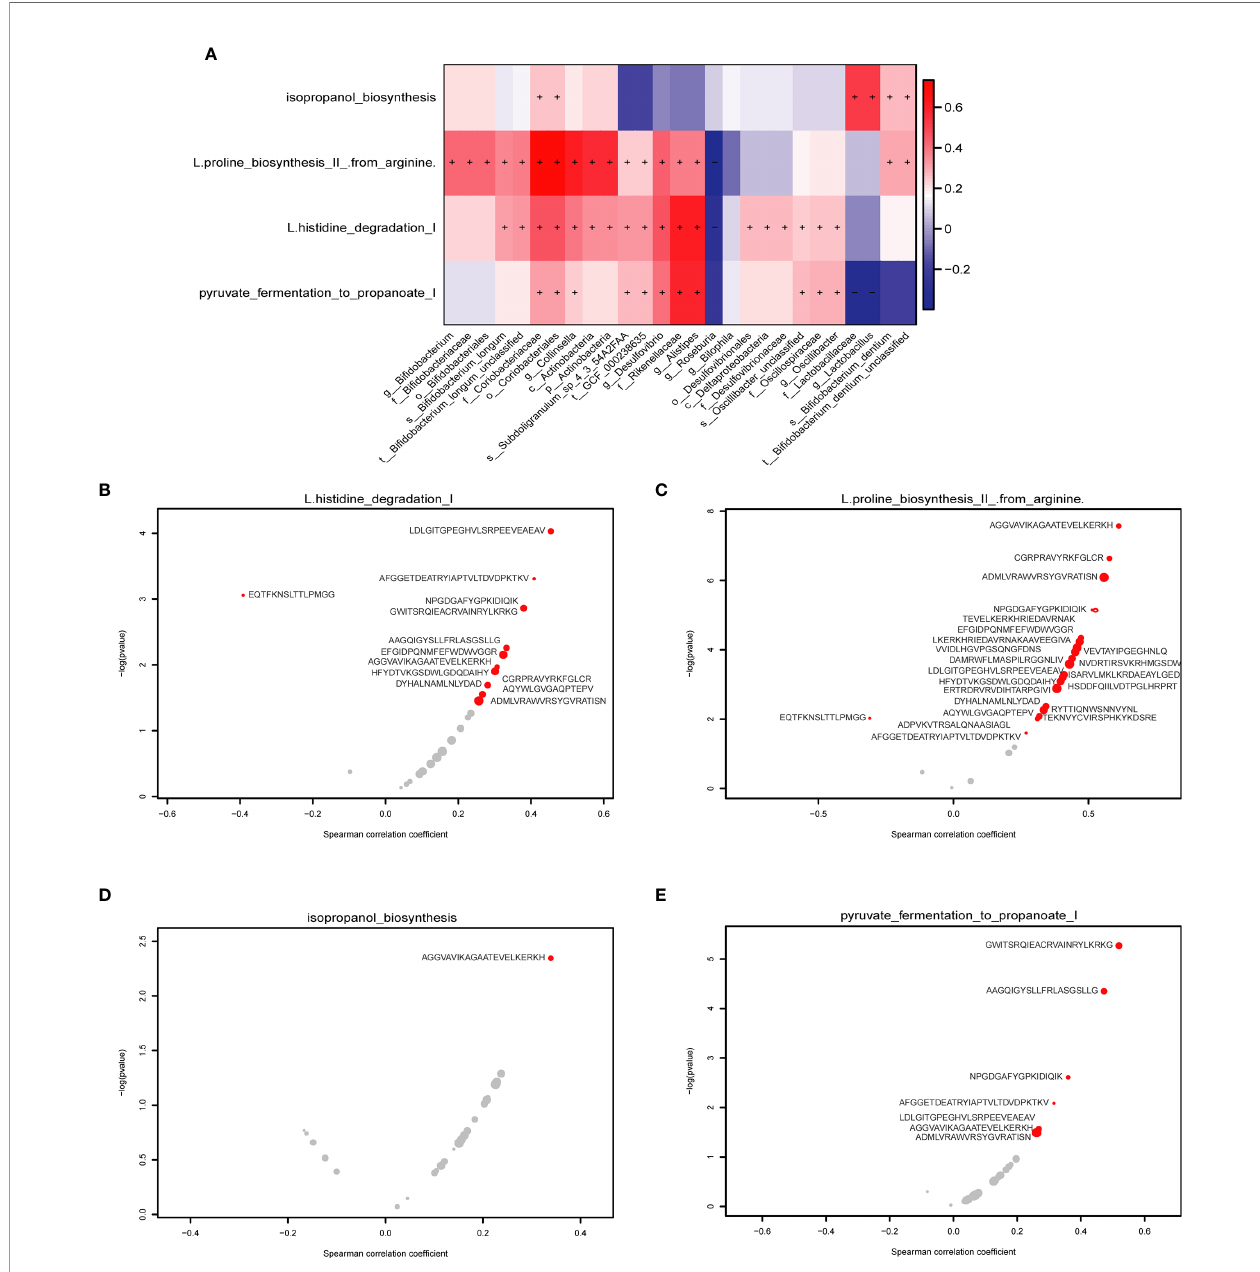
FIGURE 6 | Correlations between gut MES and functional pathways. (A) The heatmap shows the correlations between 27 potential bacterial biomarkers and functional pathways. The right panel shows the size of the correlation coef fi cient, with: red representing a positive correlation; blue representing a negative correlation, “ + ” and “ − ” in each lattice representing signi fi cant positive and negative correlations, respectively (P < 0.05). (B) Correlations between the L-histidine degradation I pathway and 13 speci fi c epitope biomarkers. (C) Correlations between the L-proline biosynthesis II (from arginine) pathway and 23 speci fi c epitope biomarkers. (D) Correlations between the isopropanol biosynthesis pathway and 1 speci fi c epitope biomarker. (E) Correlations between the pyruvate fermentation to propanoate I pathway and 7 speci fi c epitope biomarkers. The horizontal axis represents the spearman correlation coef fi cient, the vertical axis represents -log(pvalue), the red dot represents the marker with signi fi cant correlation, and the gray represents the insigni fi cant. The size of the dot represents the relative abundance of the